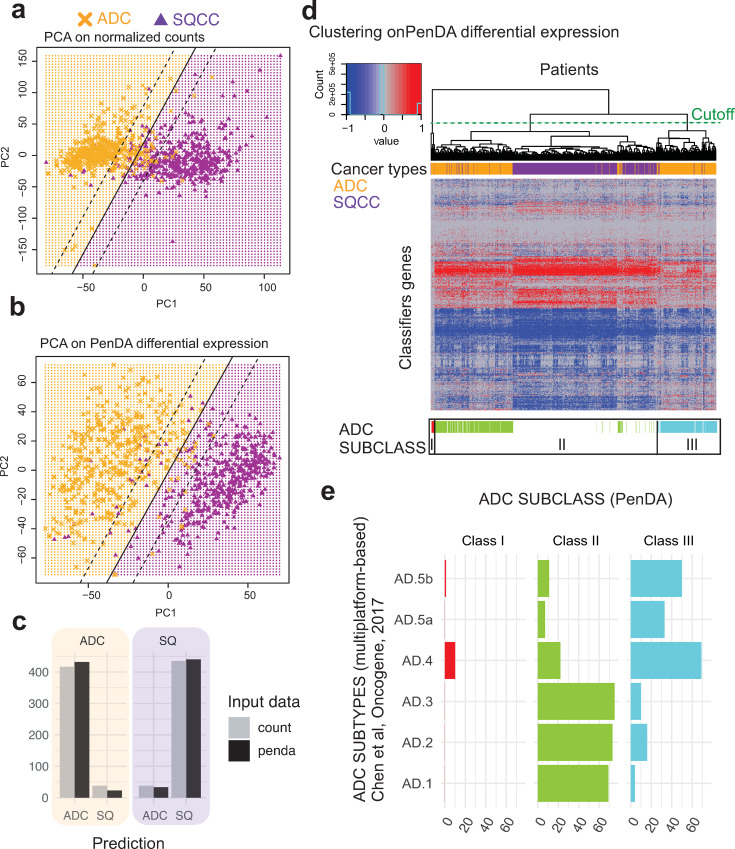
Genetic deregulations efficiently classify cancer histologies.(a, b) Principal Component Analysis on TCGA non-small-cell lung cancers (ADC and SQCC cohorts) using normalized count matrix (a) or PenDA differential expression matrix (b) as input. Full lines represent the decision boundary between ADC and SQCC histologies (using a linear SVM classifier on the first two principal components). Dashed lines represent the upper and lower margins of the decision boundary. Each symbol represents an individual sample (orange crosses for ADC, purple triangles for SQCC). (c) At the bottom, the bar plot represents the histology predictions based on the SVM classifier. SVM on PenDA predicts correctly 95% of ADCs and 93% SQCCs. SVM on count predicts correctly 92% of ADCs and 92% SQCCs. (d) Heatmap of PenDA differential expression matrix applied to a specific set of classifier genes (n = 875) in TCGA non-small-cell lung cancers: ADC (orange) and SQCC (purple). Two hierarchical clustering analyses were performed: using Euclidean distance to sort genes and using Pearson correlation-based distance to classify patients, with a complete linkage function in both cases. ADC subclasses (color-coded, class I to III) are defined according to the dendrogram cutoff n = 3 groups (cutting section = green dashed line). (e) Graphical representation of the contingency table between ADC subtypes (Chen et al,) and ADC subclasses (PenDA analysis). Each bar plot represents the total number of patients in each cell of the table.